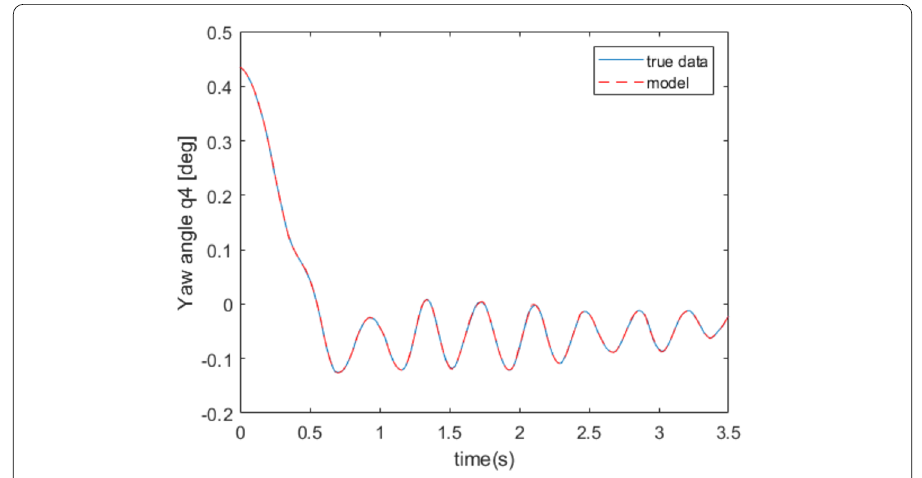
Figure 25 Model match between the identified nonlinear model with delay against the measured yaw angle response